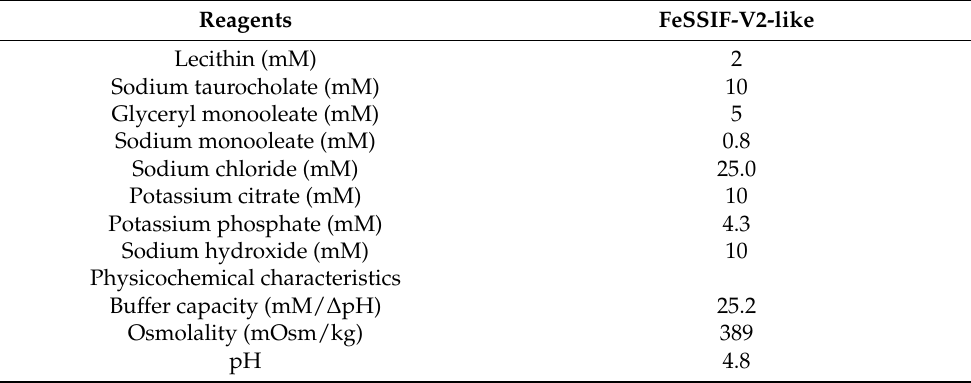
Table 2. Composition and physicochemical characteristics of biorelevant FeSSIF-V2-like media for dissolution experiments simulating the small intestine environment in a mouse in a fed